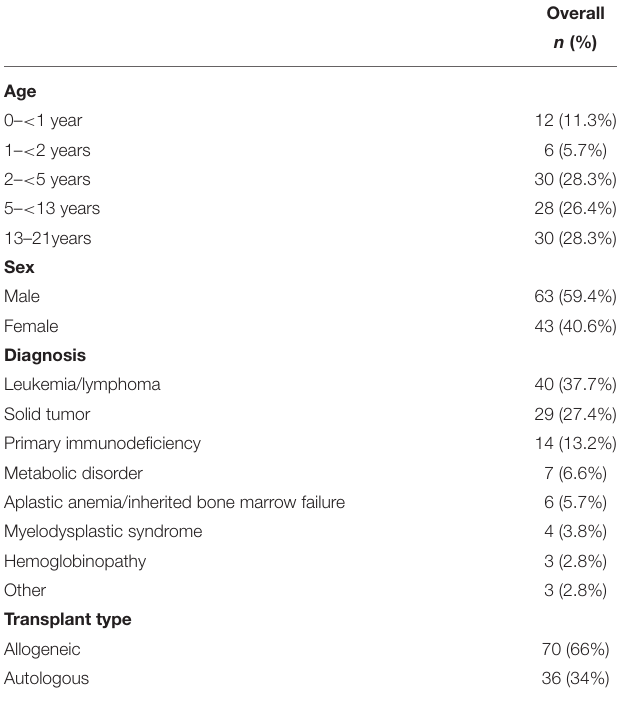
TABLE 1 | Demographic and clinical characteristics of study cohort ( n = 106).